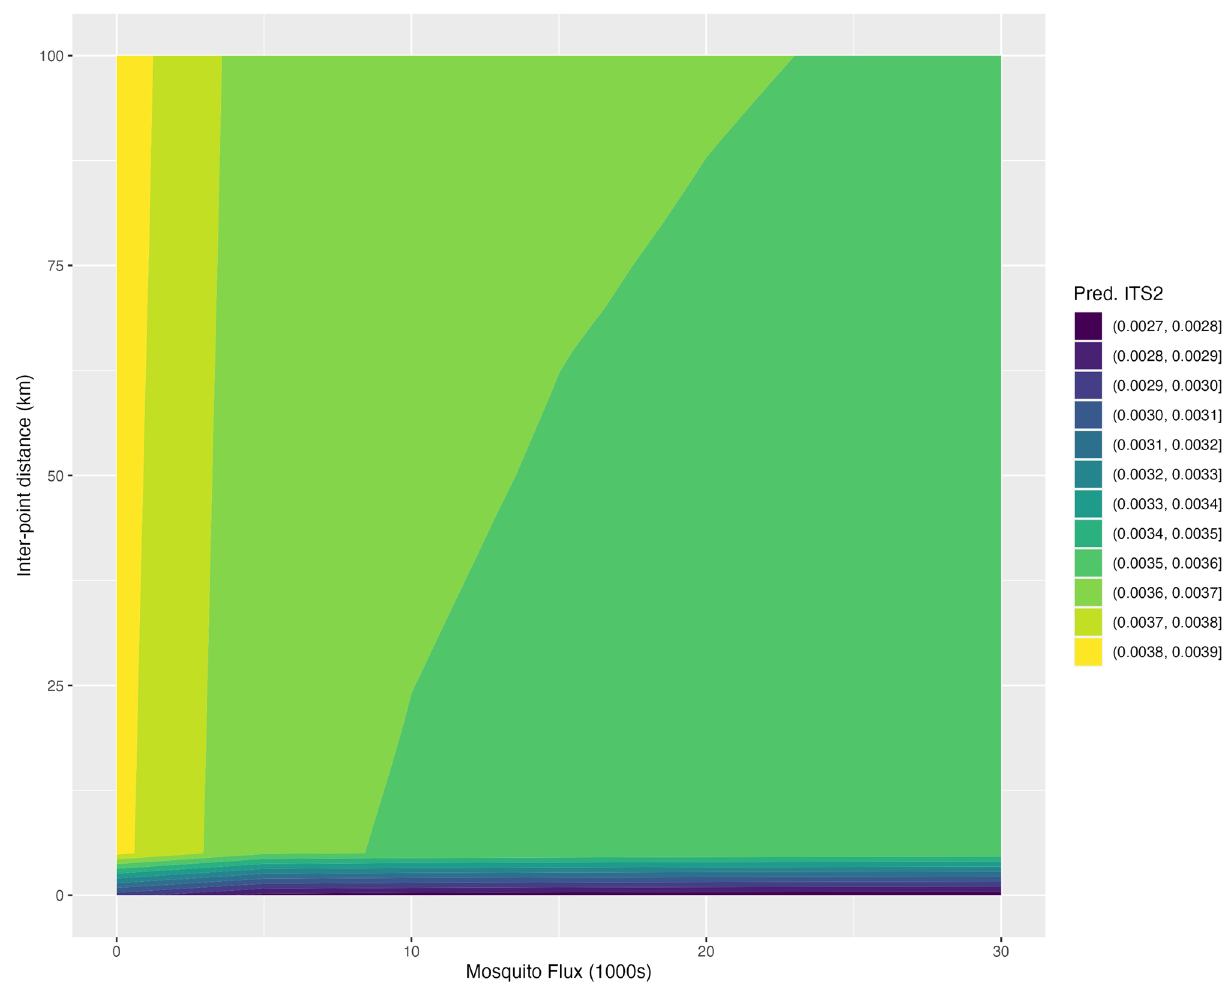
Figure 7. Predicted ITS2 pairwise genetic distance (indicated by fill colour) as a function of inter-point distance (the spatial distance and spatial proximity variables taken together) and potential tiger mosquito flux in the zero-inflated beta regression Model 6. Predictions are shown inter-point distances between 0 and 100 km and potential tiger mosquito fluxes between 0 and 30,000, setting the sampling years to 2011 and 2015, and arbitrarily selecting a sample pair and its associated provinces for purposes of the model’s random